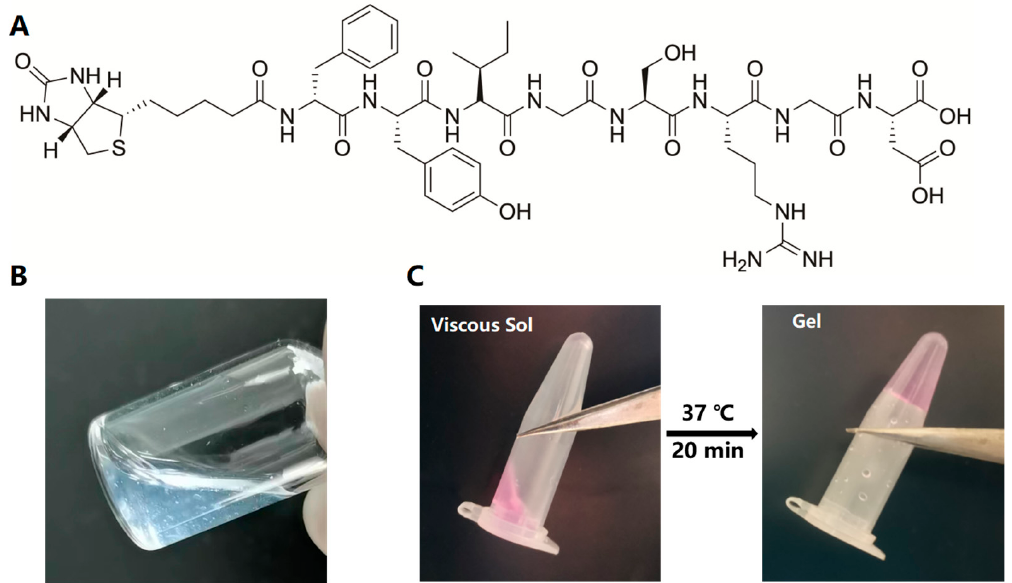
Figure 4. Construction of the PDLSC–SupraGel culture system. ( A ) Chemical structure of the Biotin– DFYIGSRGD peptide. ( B ) Peptide self-assembly to form SupraGel. ( C ) Sol of the SupraGel with PDLSC suspension becoming a stable hydrogel after 20 min incubation at 37 °C.